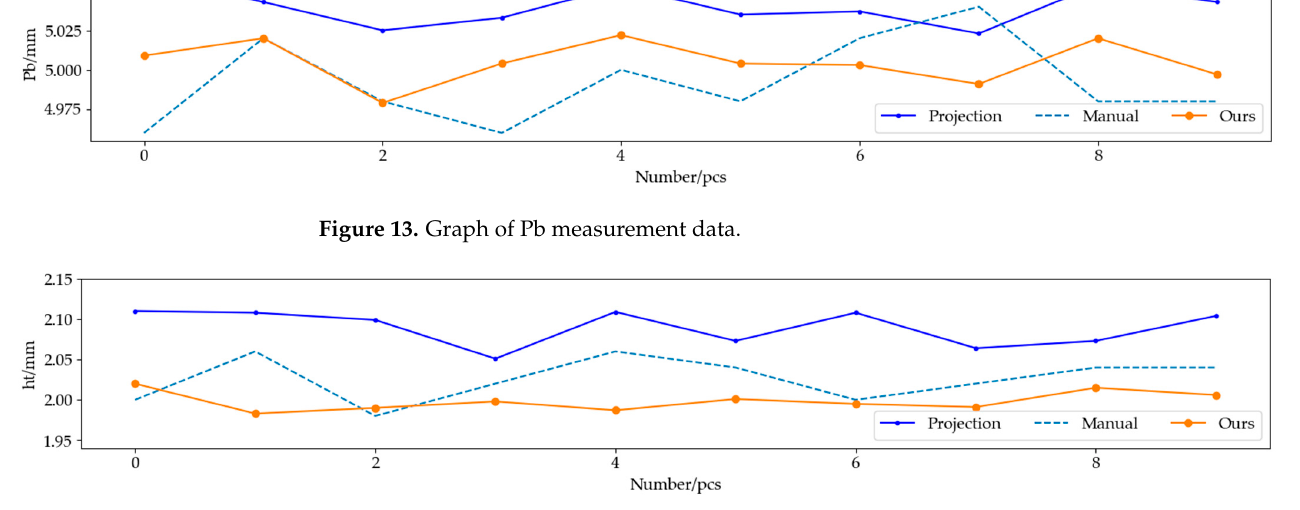
Figure 14. Graph of ht measurement data.